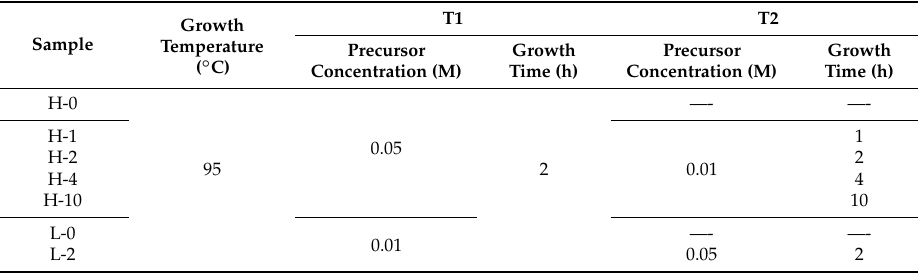
Table 1. Growth conditions of the